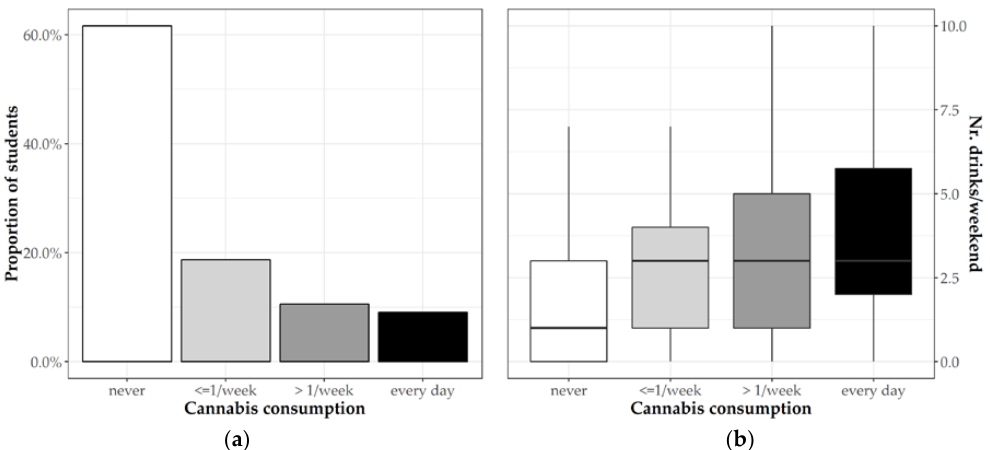
Figure 3. ( a ) Frequency of cannabis consumption among students and ( b ) the association between alcohol and cannabis consumption.